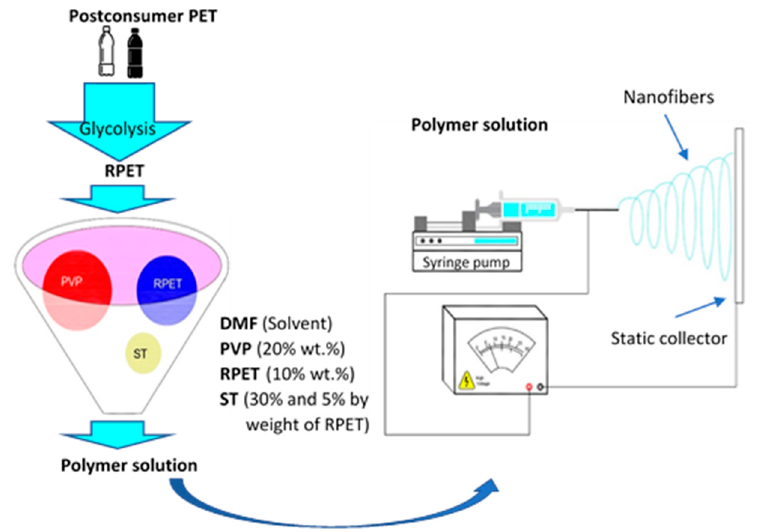
Figure 1. Schematic of the preparation of the RPET/PVP/ST nanofibers.